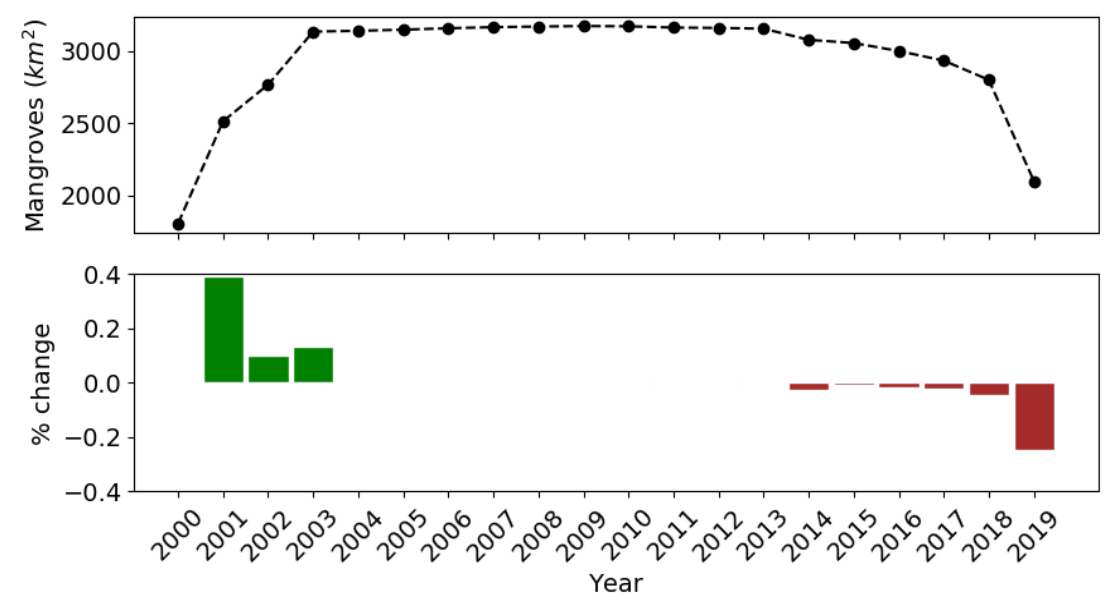
Figure 5. Mangrove extent over time for the Niger Delta site. Years 1990–1999 (inclusive) were excluded from analysis because the class maps for those years contained less than 60% valid data.